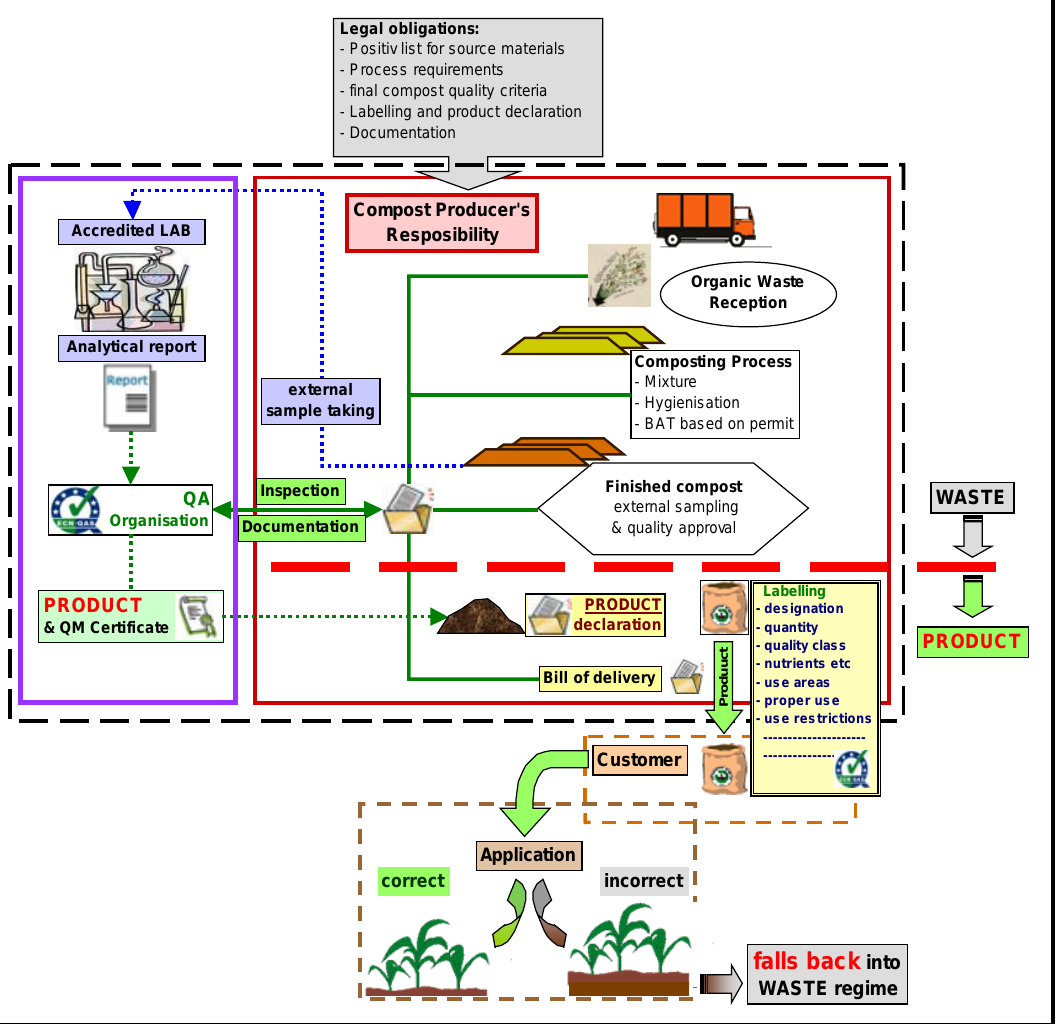
Figure 19: Product certification scheme including documentation, external inspection and sample taking based on comprehensive End of Waste legislation for compost (example: AT,